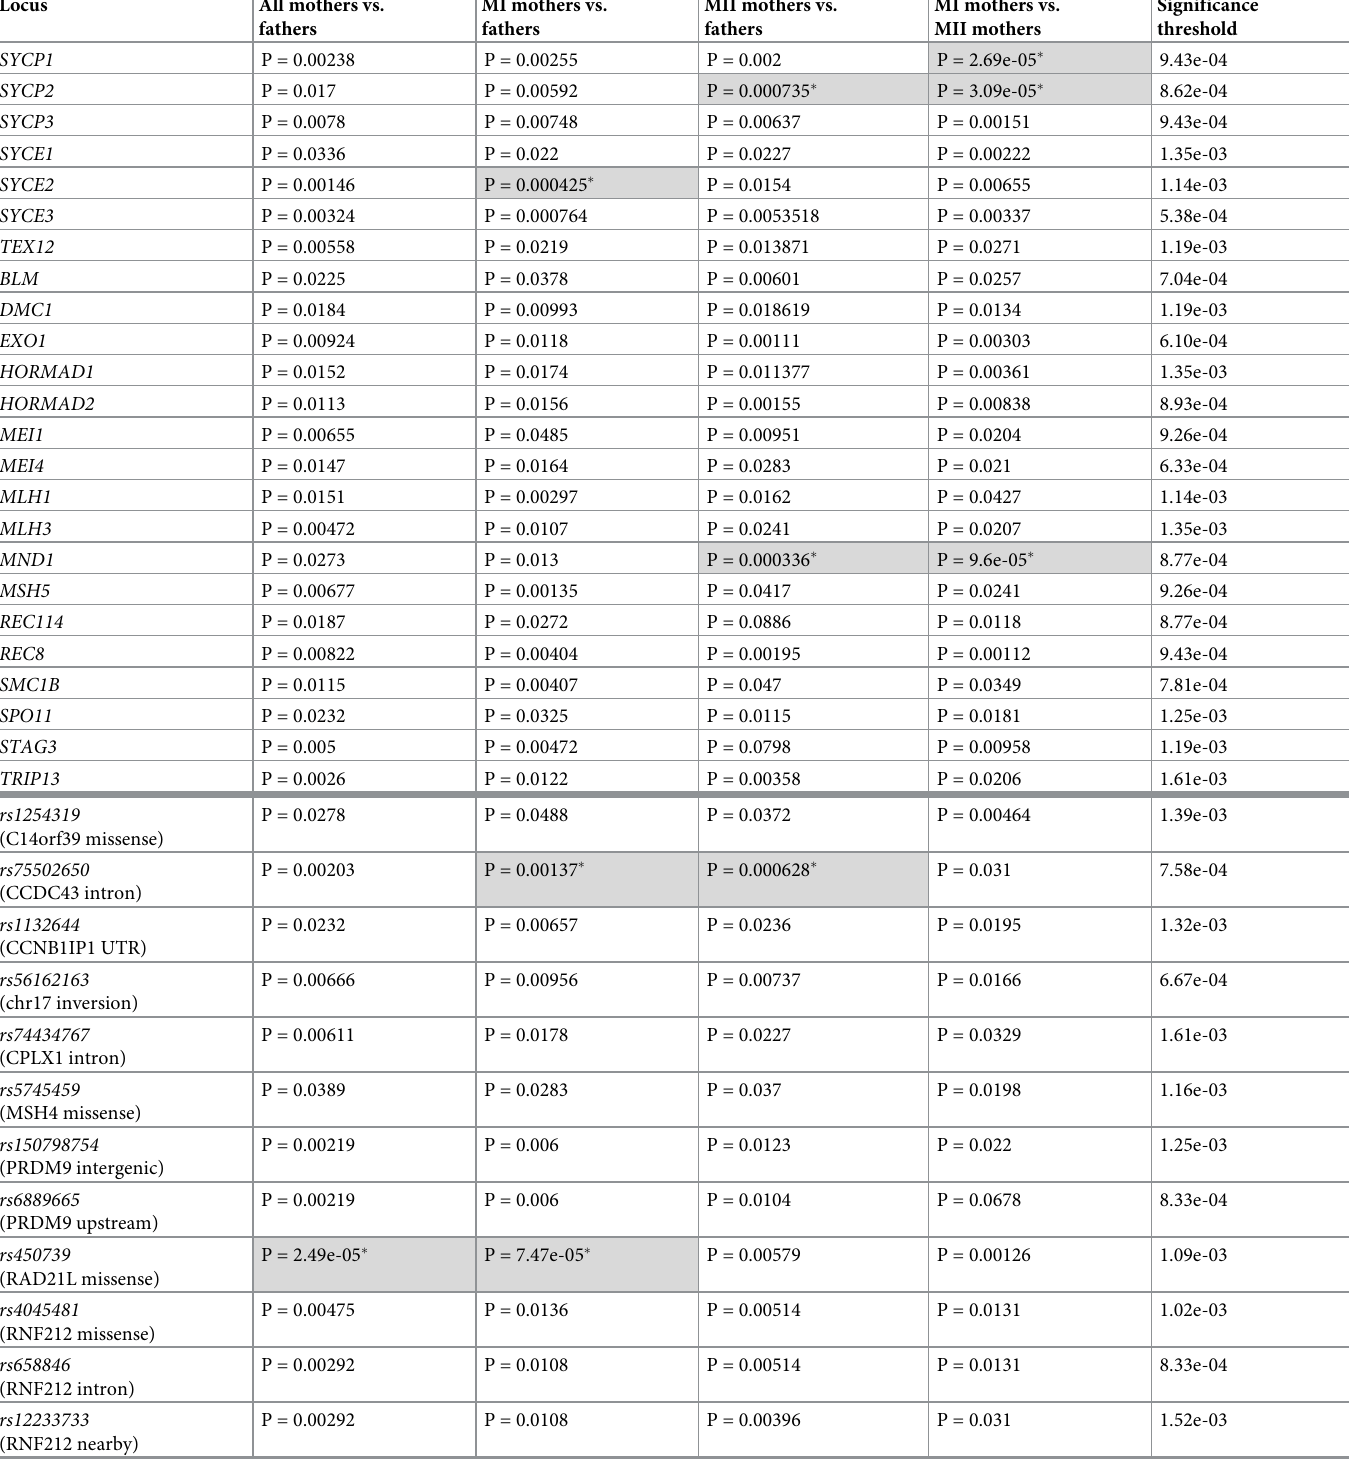
Table 2. Candidate gene results.